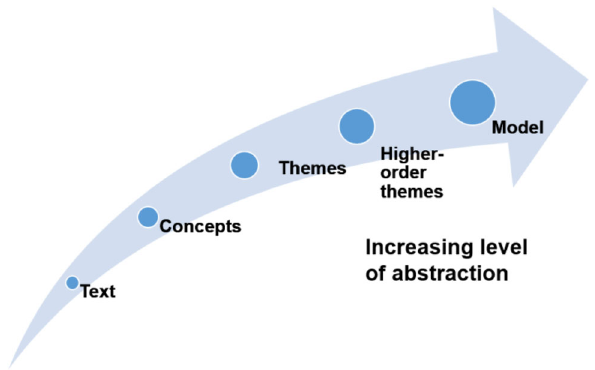
Fig. 3 Levels of interpretation in thematic analysis. Source Adapted from Cruzes et al.